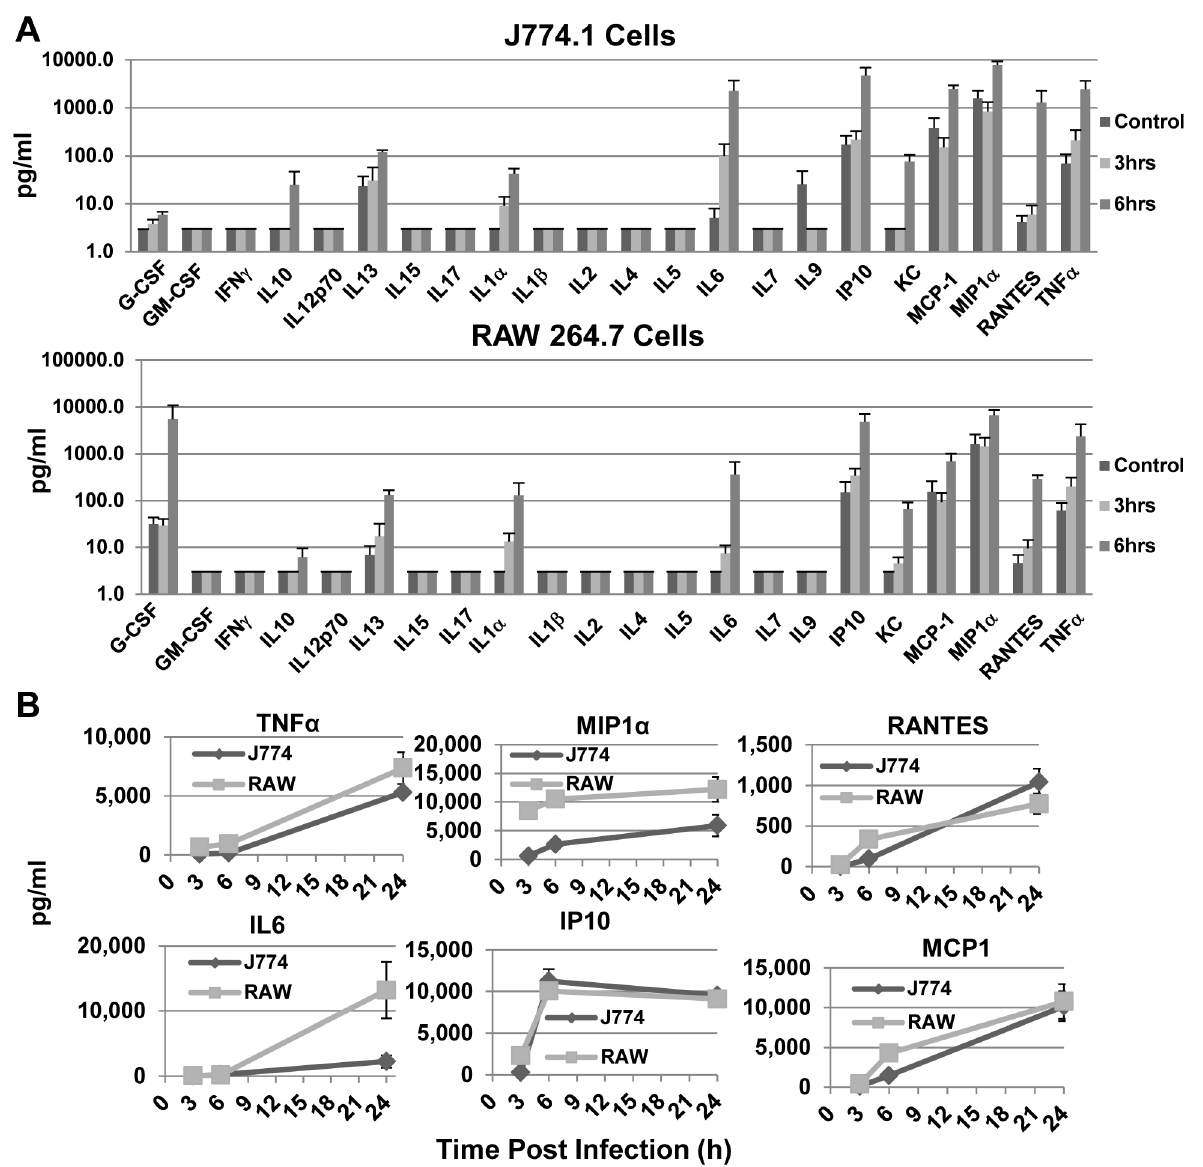
Figure 3. Proinflammatory cytokines are induced by X-31 exposure at early time points post exposure. A. Supernatants from cells 3 h or 6 h after exposure to X-31, along with those from mock infected controls, were assayed for CK/CHK by multiplexed fluid phased antibody based analysis. Cytokine concentrations were calculated based on known concentration standards run at the same time. Data shown are the mean 6 SEM, n=5 independent experiments. B. Production kinetics of selected CK/CHK induced by FLUA. The charts illustrate commonalities and differences. TNF a and IL6 showed a lag of 3–6 h whereas MIP1 a and IP10 were maximal by 3 h. The RANTES and MCP1 responses were intermediate. RAW 264.7 cells responded faster and to higher levels than J774.A1 cells especially at 3 and 6 h pi. Means 6 SEM, n=3 independent